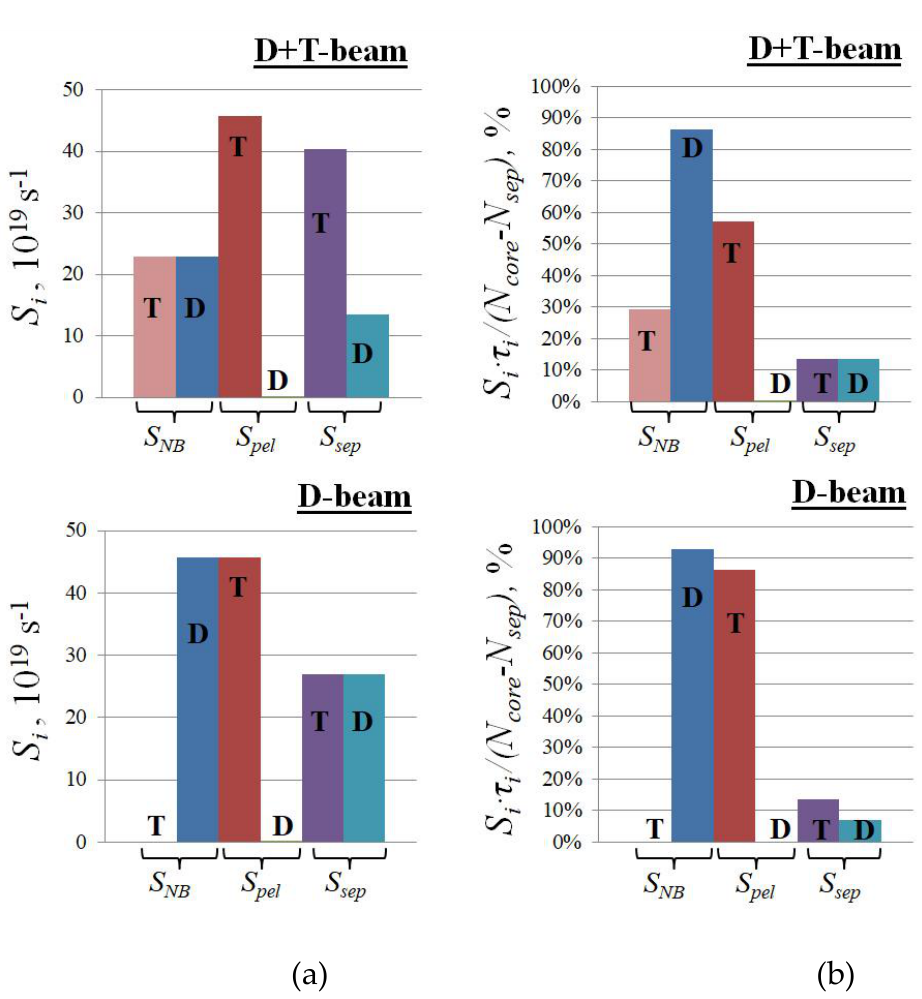
Figure 4. ( a ) Sources of deuterium and tritium in the plasma core, originating from the neutral beam S NB , pellet injection S pel , and divertor region S sep for the D + T ( top ) and D ( bottom ) beams. The absolute values of the particle flux sources are given. n e = 8.5 × 10 19 m − 3 , D/ χ e = 0.4. For the D + T and D beams, f coreT = 0.75 and 0.5, respectively. ( b ) Fractions of particles from different sources with allowance for their lifetimes.